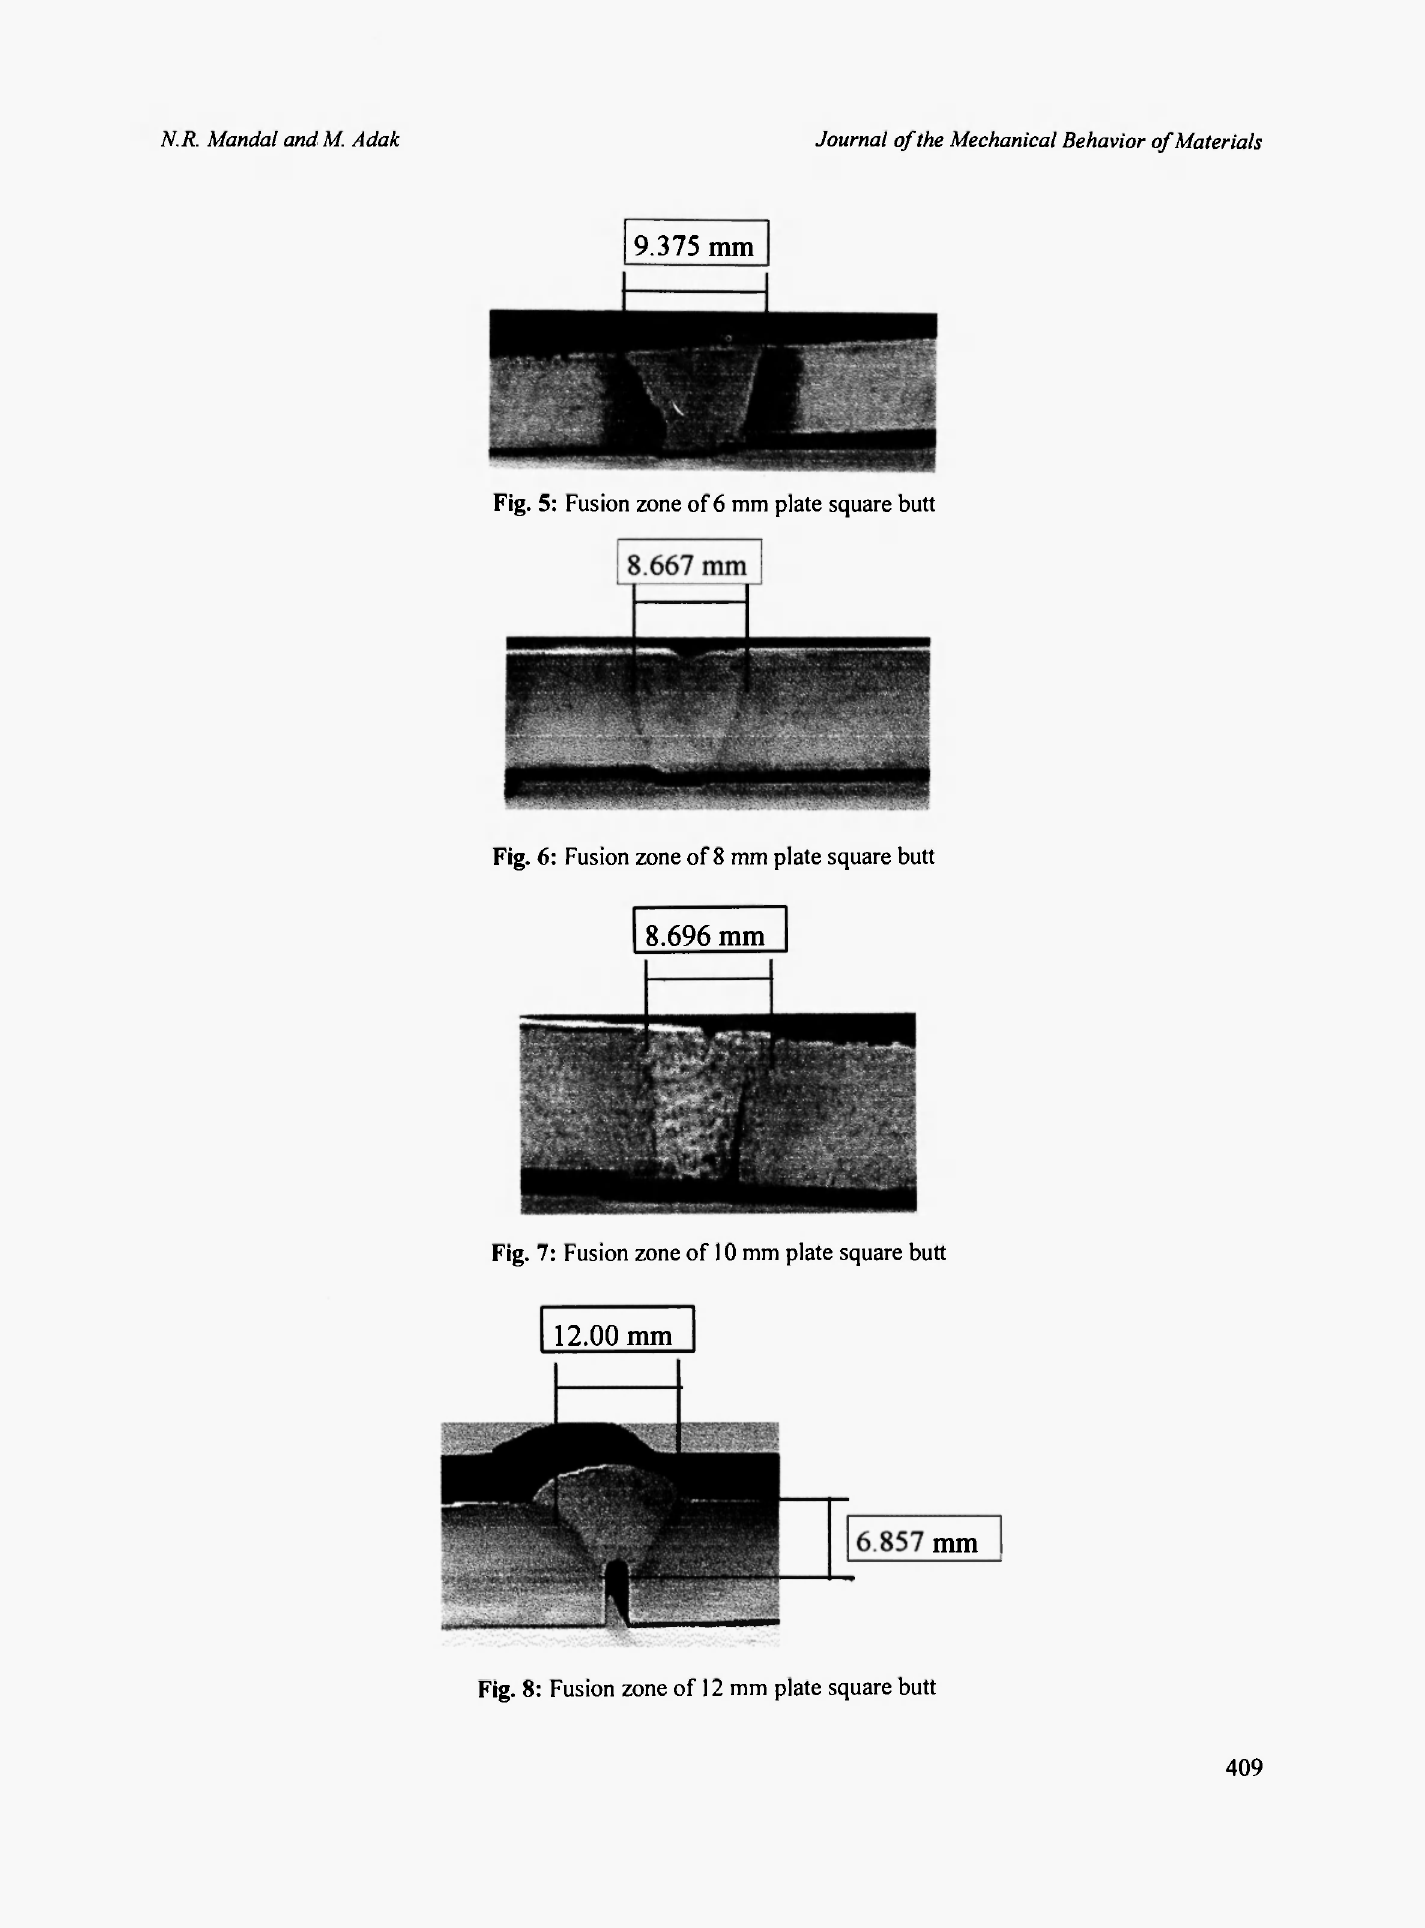
Fig. 5: Fusion zone of 6 mm plate square butt